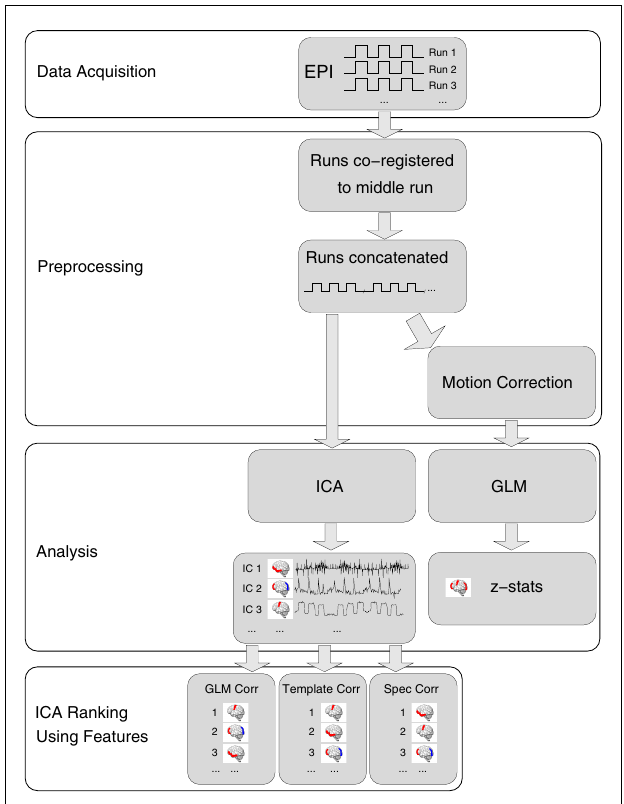
FIGURE 1 |A schematic representation of data processing steps for each patient in the main analysis .